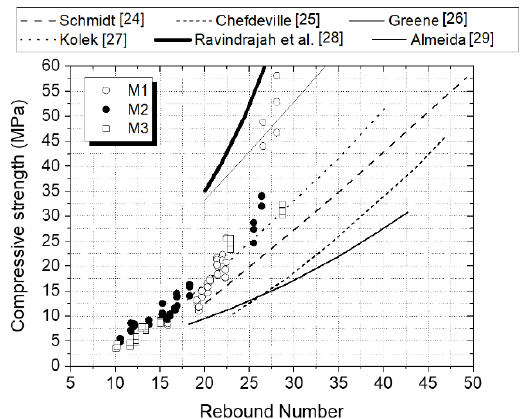
Figure 9 – Comparison between experimental data and correlation curves reported in the literature.